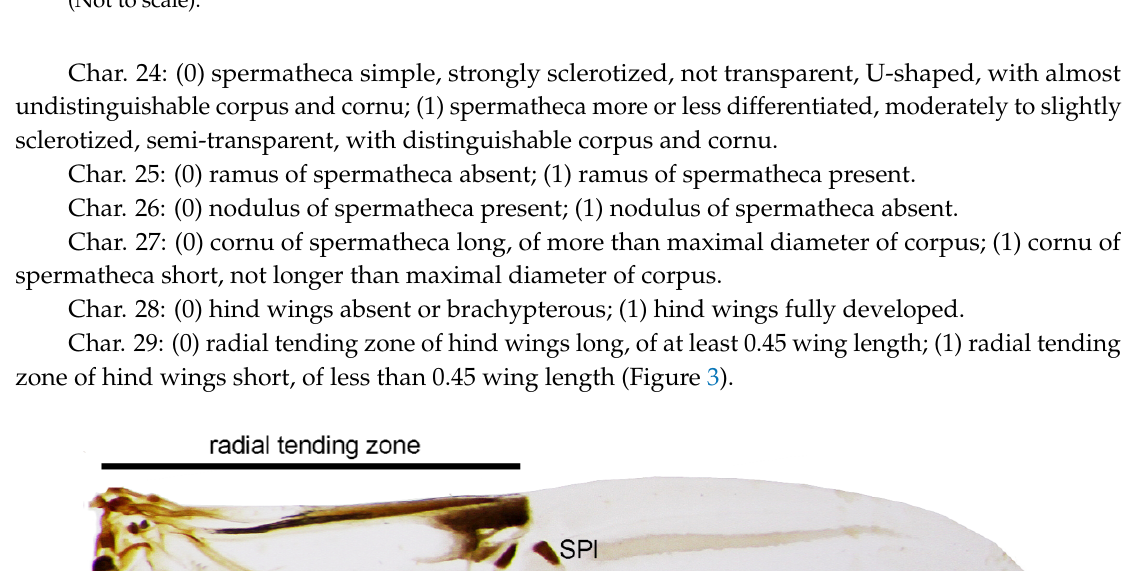
Figure 2. Spiculum ventrale (female eighth sternite) of Acentrus histrio . “Arch”-like arms ( a ), apodeme ( b ). (Not to scale).